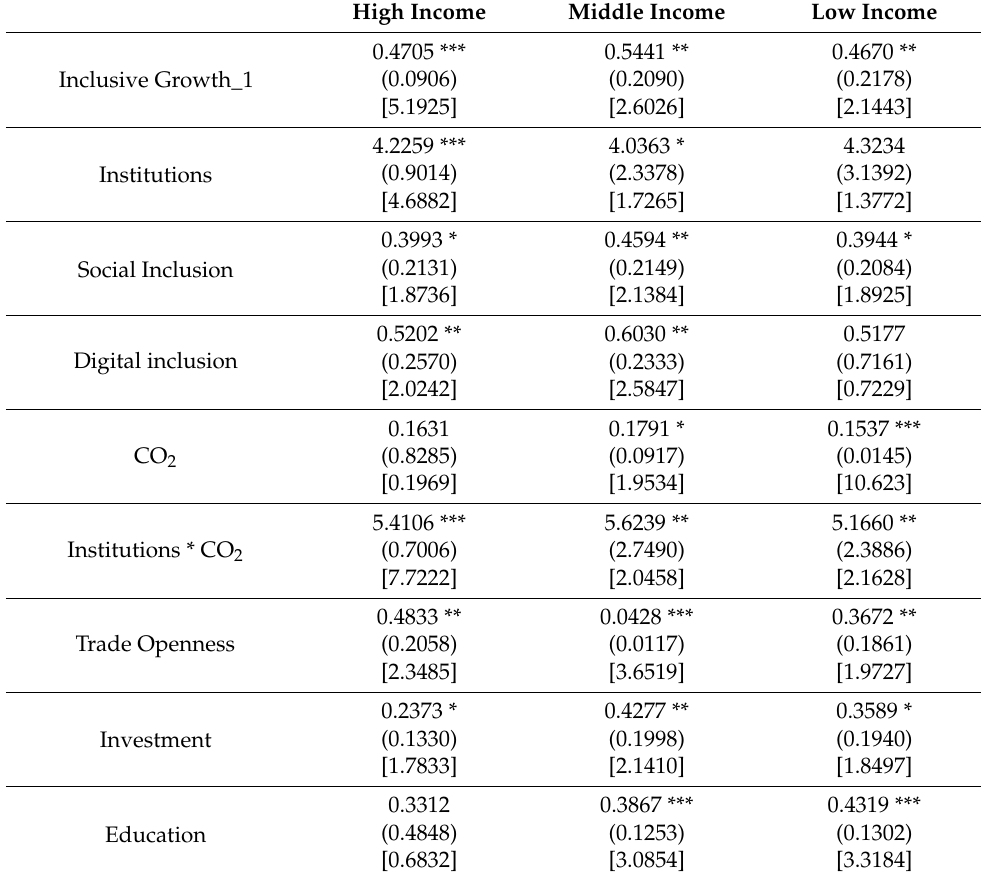
Table 4. Results for the impact of CO 2 on inclusive growth with institutions * CO 2